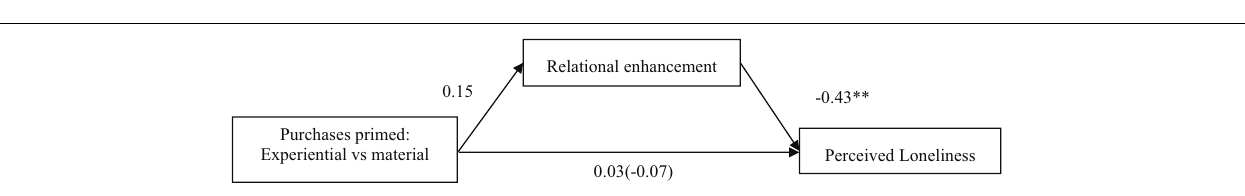
FIGURE 4 | Mediation analysis (in low loneliness primed condition): relational enhancement as a mediator (Experiment 2). Note * p -values < 0.05; ** p -values < 0.01; *** p -values < 0.001; NS,